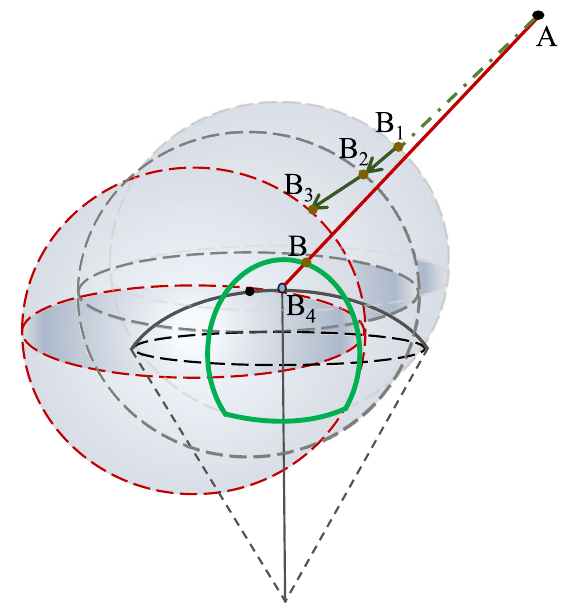
Fig. 5 Comparison of calculating